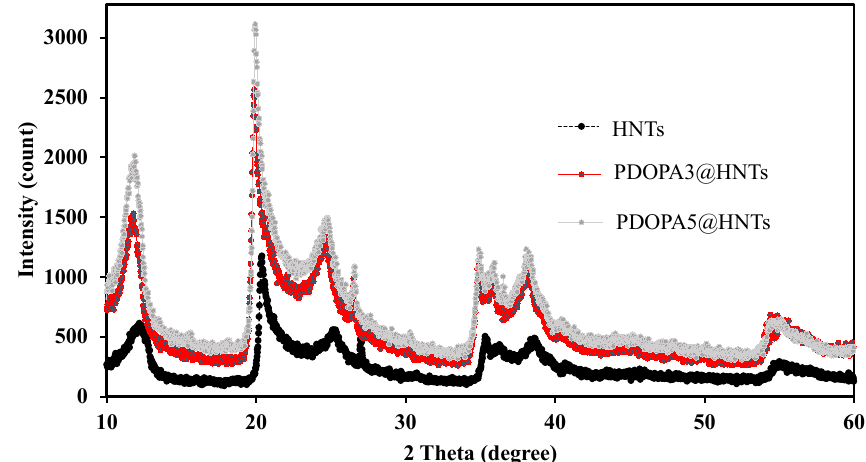
Figure 4. XRD patterns of HNT, PDOPA3@HNT, and PDOPA5@HNT particles. Three different antioxidant tests were performed for PDOPA@HNTs. The TPC value was determined for aqueous solutions of PDOPA@HNTs at a concentration of 2.0 mg/mL. As seen in Figure 5a, the TPC value of HNT was determined to be 150.5 ± 45.9 µmol GA equivalent (eq). TPC values for PDOPA1@HNT, PDOPA3@HNT and PDOPA5@HNT coatings were found as 405.5 ± 25.0, 750.0 ± 69.9 and 1348.3 ± 371.7 µmol GA eq, respectively. As the number of coatings was increased, the TPC values were also increased almost linearly.